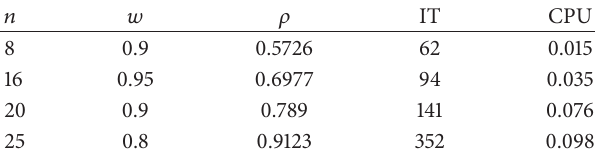
Table 2: 𝜌 , IT, and RES of QSOR.